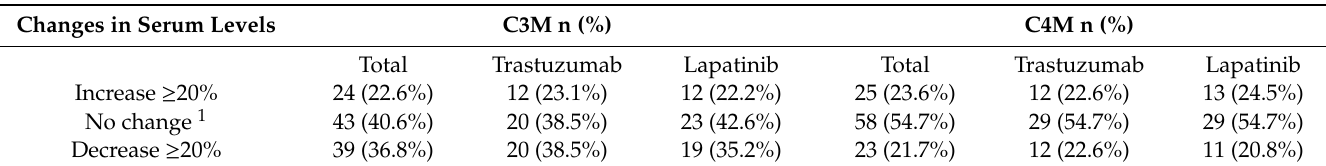
Table 3. Changes in serum levels of C3M and C4M between baseline and surgery according to treatment